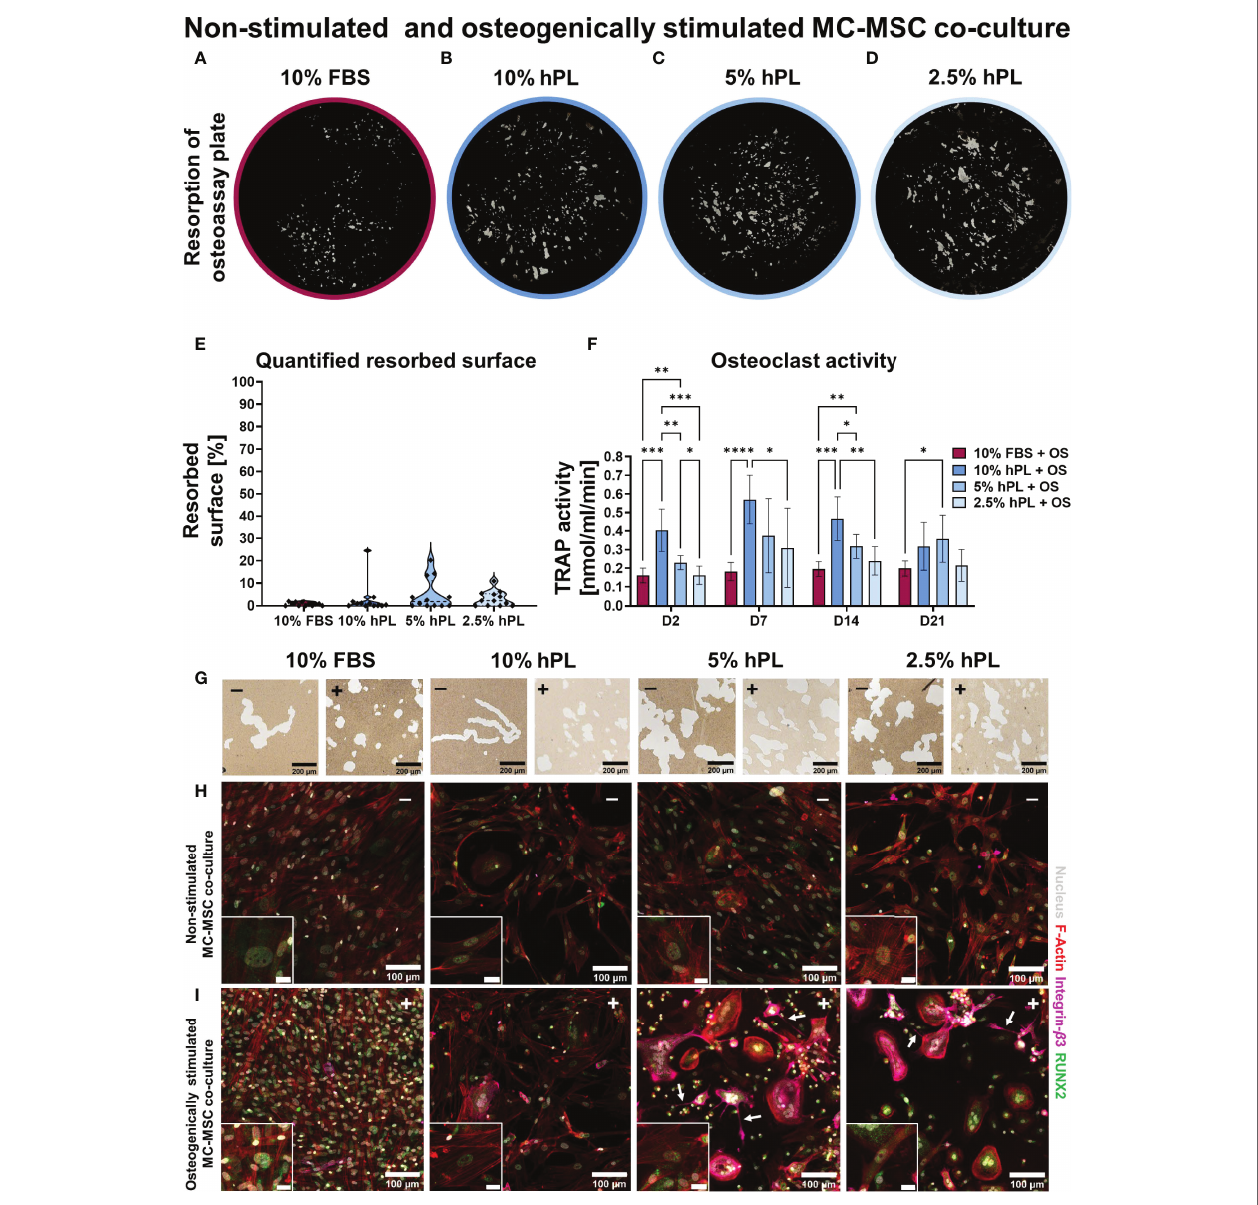
FIGURE 4 | (A – D) Von Kossa stained decellularized resorption plates of osteogenically stimulated MC-MSC co-cultures. (E) Quanti fi cation of resorbed area, p =ns (Kruskal-Wallis test). (F) TRAP activity quanti fi cation, p <0.05 for culture time, culture condition and their interaction (two-way ANOVA and Turkey ’ s post hoc tests within each time point). (G) Micrographs of osteo assay plates indicating resorption trenches and resorption pits of non-stimulated co-cultures (-) and osteogenically stimulated co-cultures (+). (H) Micrographs of non-stimulated MC-MSC co-cultures, and (I) osteogenically stimulated MC-MSC co-cultures, stained for F-Actin (red) the nucleus (gray), Integrin- b 3 (pink) and RUNX2 (green). Scale bar in insert is 20 µm. Asterisks in fi gures represent results of post hoc analyses (* p < 0.05, ** p < 0.01, *** p < 0.001, **** p < 0.0001). fetal bovine serum (FBS), human platelet lysate (hPL), monocytes (MCs), mesenchymal stromal cells (MSCs), tartrate resistant acid phosphatase (TRAP), osteogenic supplements (OS), runt-related transcription factor 2